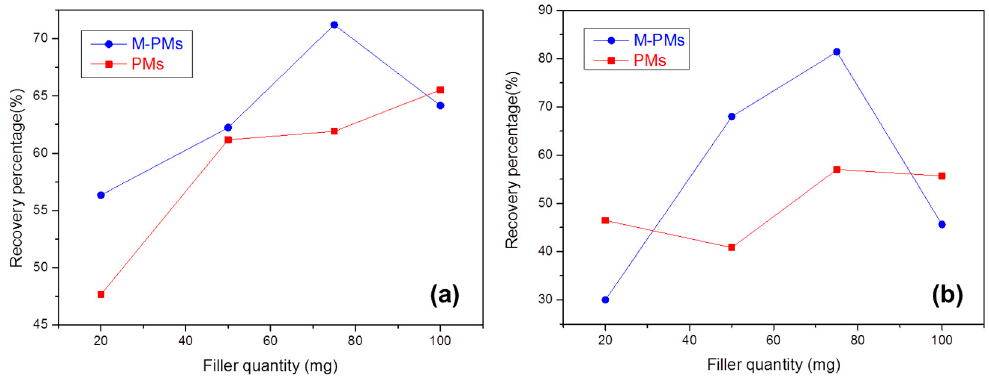
Figure 7. Recovering percentages of MG ( a ) and Leuco-MG ( b ), by using the Molecularly Imprinted Solid-Phase Extraction (MISPE) column filled with M-PMs or PMs.